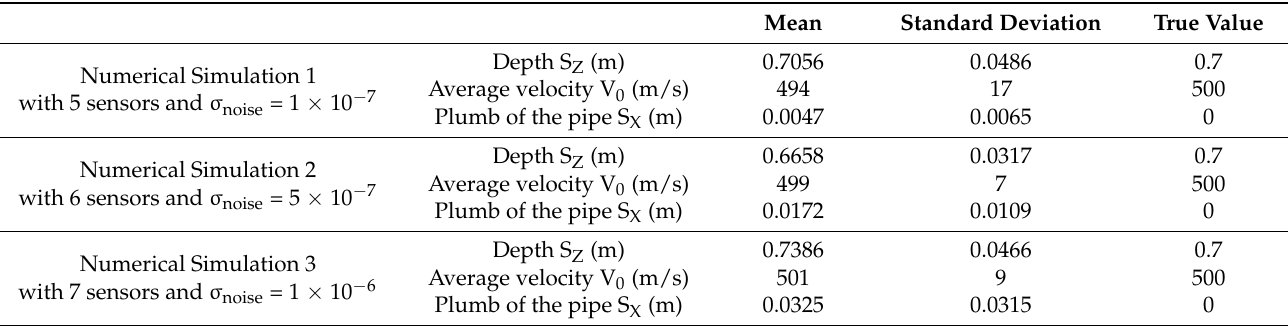
Table 1. Statistics of the MUSIC estimator adapted to Model M1 using the Monte Carlo method (for 1000 runs, 5 sensors spaced 0.2 apart). Noise is applied to the propagation times, which are in the order of a millisecond.